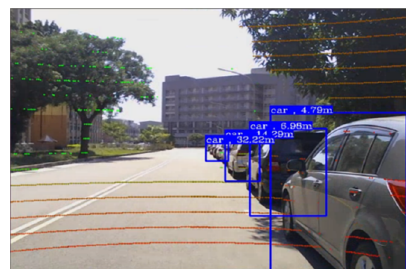
Figure 19. Road test results.